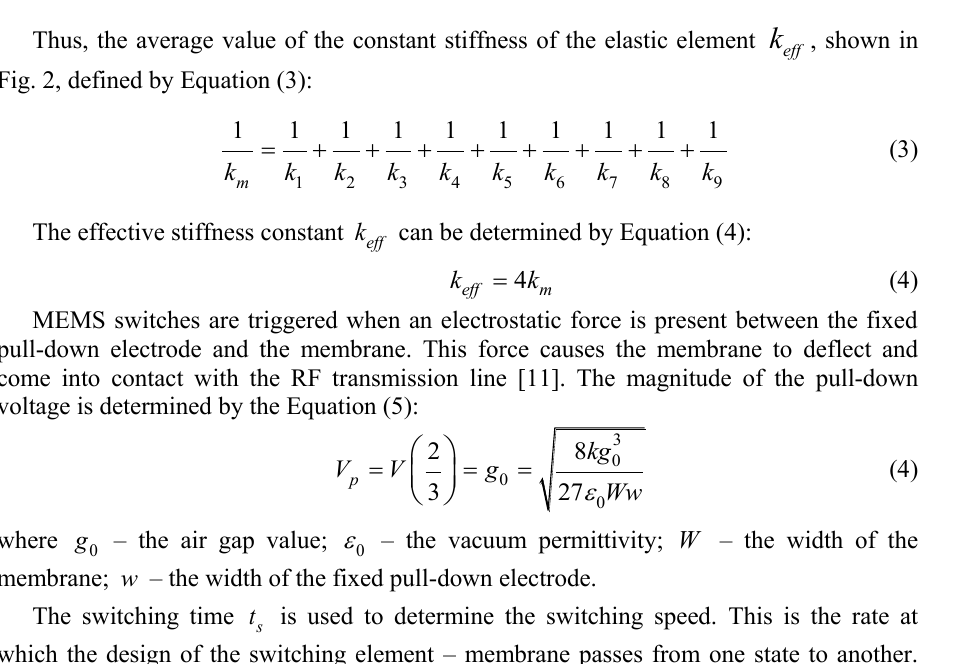
Fig. 2. An elastic suspension element having two square meanders grouped from individual elements with constant stiffness k